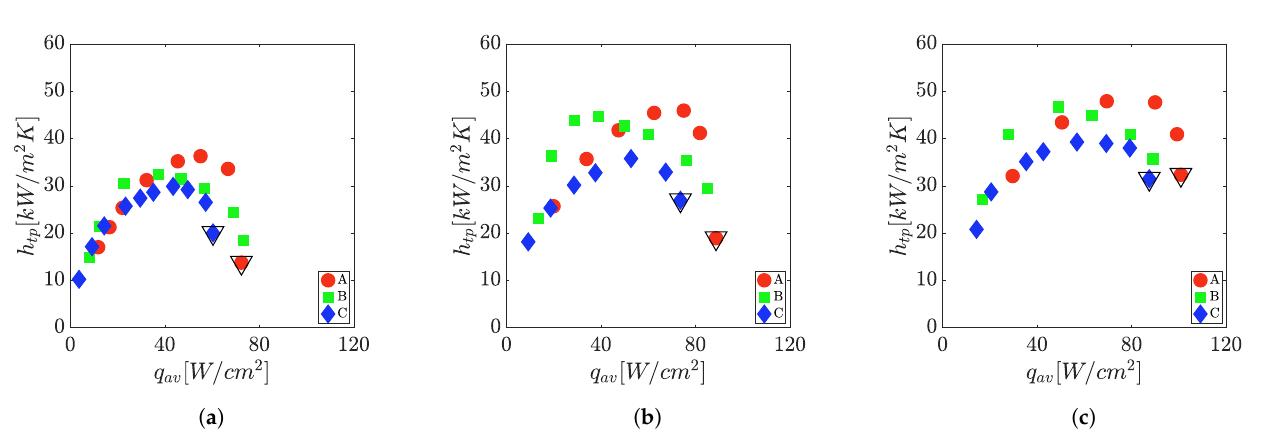
Figure 12. Comparison of h tp for the Geometry A ( ● ), Geometry B ( ■ ), and Geometry C ( ◆ ) at a nominal saturation ◦ temperature of 30 C at the outlet of the channels and different mass fluxes G : ( a ) G = 400 kg / m 2 s, ( b ) G = 580 kg / m 2 s, ( c ) G = 870 kg / m 2